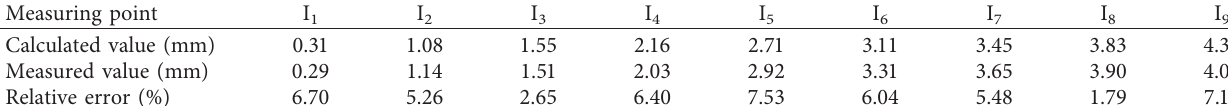
Table 4: Comparison between calculated and measured displacement values at different depths of monitoring points.